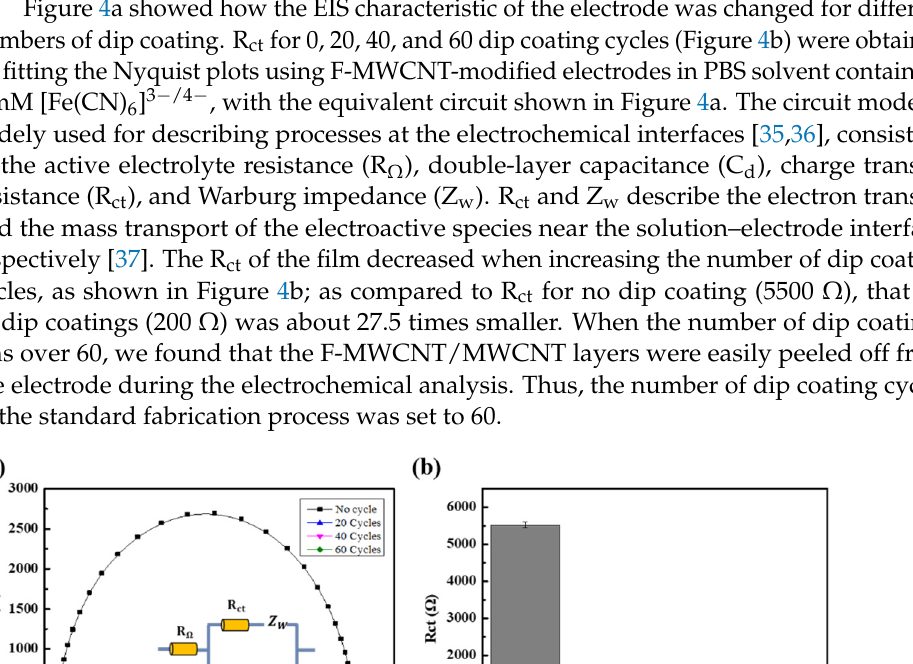
Figure 3. SEM image of the surface of MWCNT before ( a ) and after ( b ) the dip coating process with F-MWCNT solution. ( c ) Cross section of the F-MWCNT/MWCNT/PDMS layer.